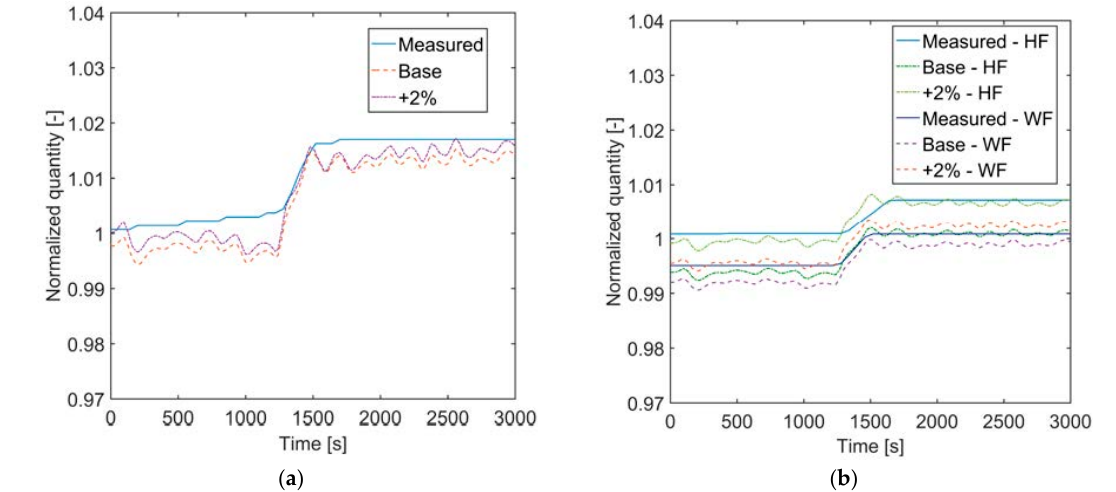
Figure 12. Measured and simulated ( a ) pressure; and ( b ) outlet temperatures for Case 2. “Base” refers to the thermal brine inlet volume flow rate as measured, whereas “+2%” to increase of the latter of 2% (HF: Heating fluid, WF: working fluid).